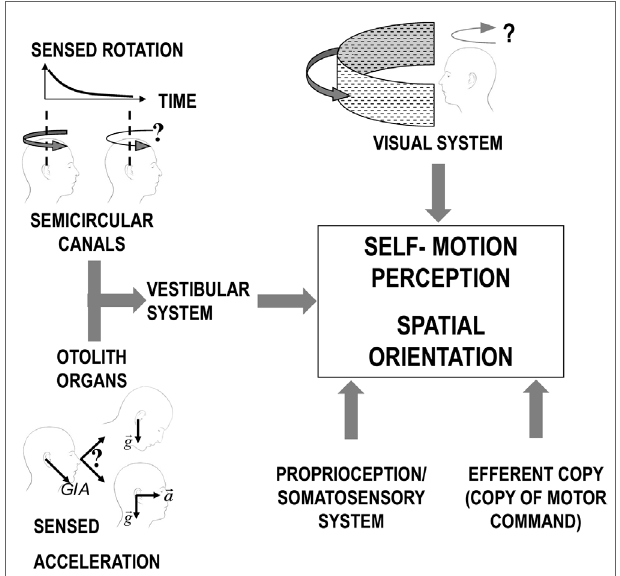
FiGURe 1 | Scheme of the different sensory systems contributing to the perception of self-motion . For the vestibular system, the otolith organs and the semicircular canals are represented separated to allow evidencing the inherent limitations of the signal from each sensor before central processing. Specifically, the semicircular canals signal in response to continuous rotation decline over time (solid black line decaying in the plot in the top/left corner) leading to a similar decrease in the sensation of self-rotation (as depicted by the change in the curve arrow above the two heads). The otolith organs, instead, perceive only the overall GIA vector (sum of gravity and inertial acceleration) and cannot, therefore, distinguish between a head tilt and linear